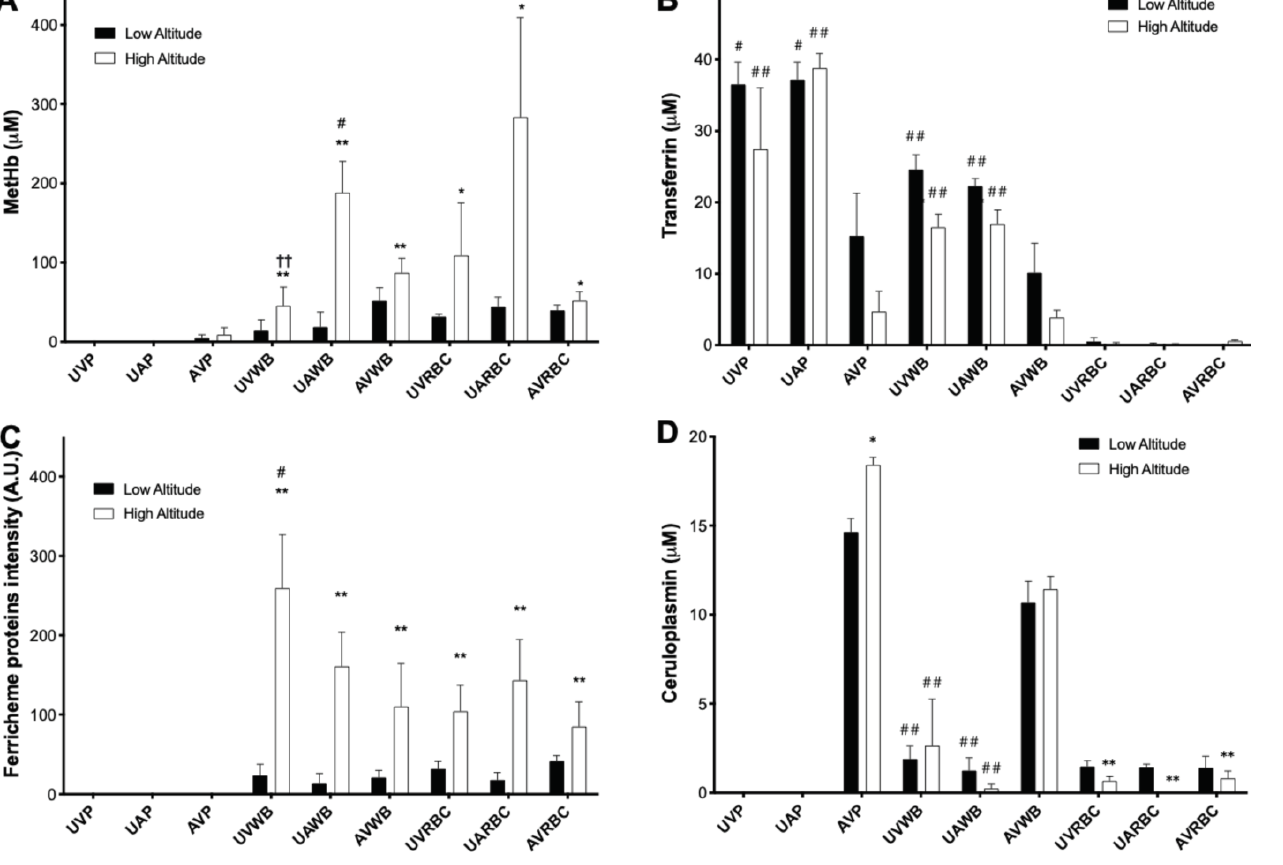
Figure 2. Metalloproteins, free radicals, and iron in blood from high and low altitude pregnant sheep. ( A – D ) Metalloproteins quantified from EPR spectra. ( A ) MetHb. ( B ) Transferrin. ( C ) Ferric heme proteins. ( D ) Ceruloplasmin. ( E ) Free radicals quantified from EPR spectra. ( F ) Plasma NTBI and total iron quantified with colorimetric methods. Because of the lack of standards, the intensity of the EPR signal of ferric heme proteins and free radicals are shown. UVP: umbilical vein plasma; UAP: umbilical artery plasma; AVP: adult (maternal) vein plasma; WB: whole blood; RBC: washed red blood cells. Two- way ANOVA with Tukey’s post -hoc tests for P, WB, or RBCs. * = p < 0.05 high vs. low altitude; † = p < 0.05 umbilical artery vs. vein; # = p < 0.05 fetus vs. mother. One symbol = p < 0.05, two symbols = p < 0.01.